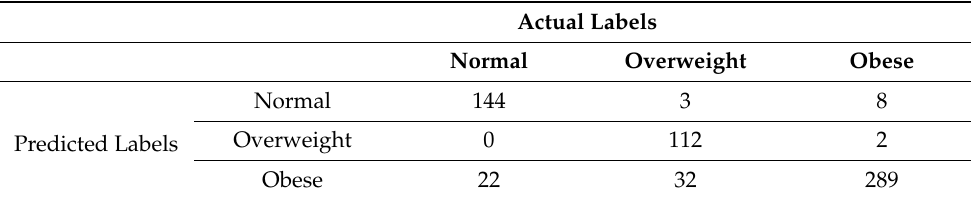
Table 3. Confusion matrix for random forest implementation for determining obesity category based on a single visit. Actual Labels Normal Overweight Obese Normal 144 Predicted Labels 112 2 Obese 32